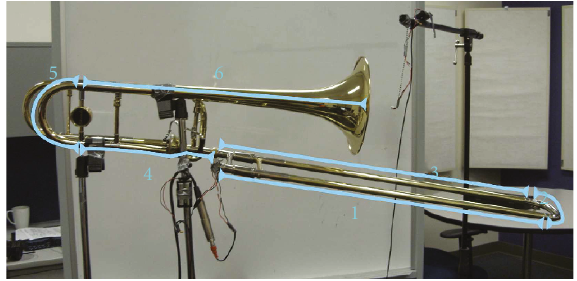
Figure 18: Trombone tubular components corresponding to Table